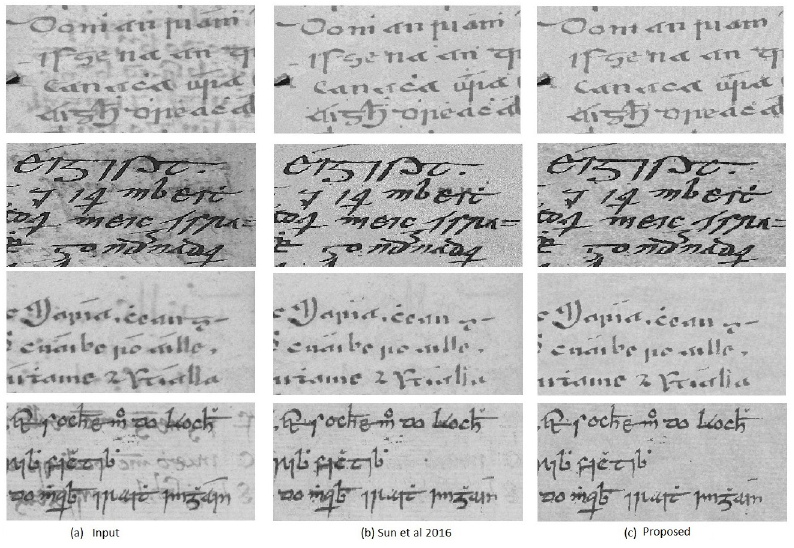
Fig 2. Visual comparison of bleed-through removal: (a) input degraded image, (b) restored image using [8], and (c) restored image using the proposed method.